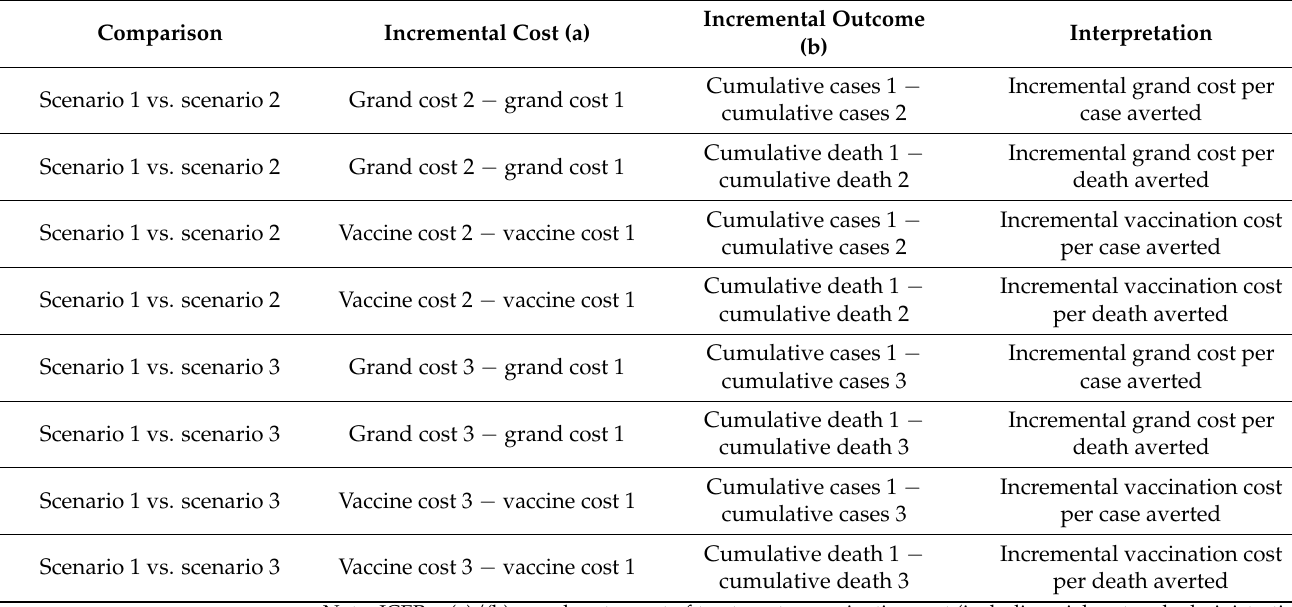
Table 1. Incremental cost-effectiveness ratio (ICER) of interest.